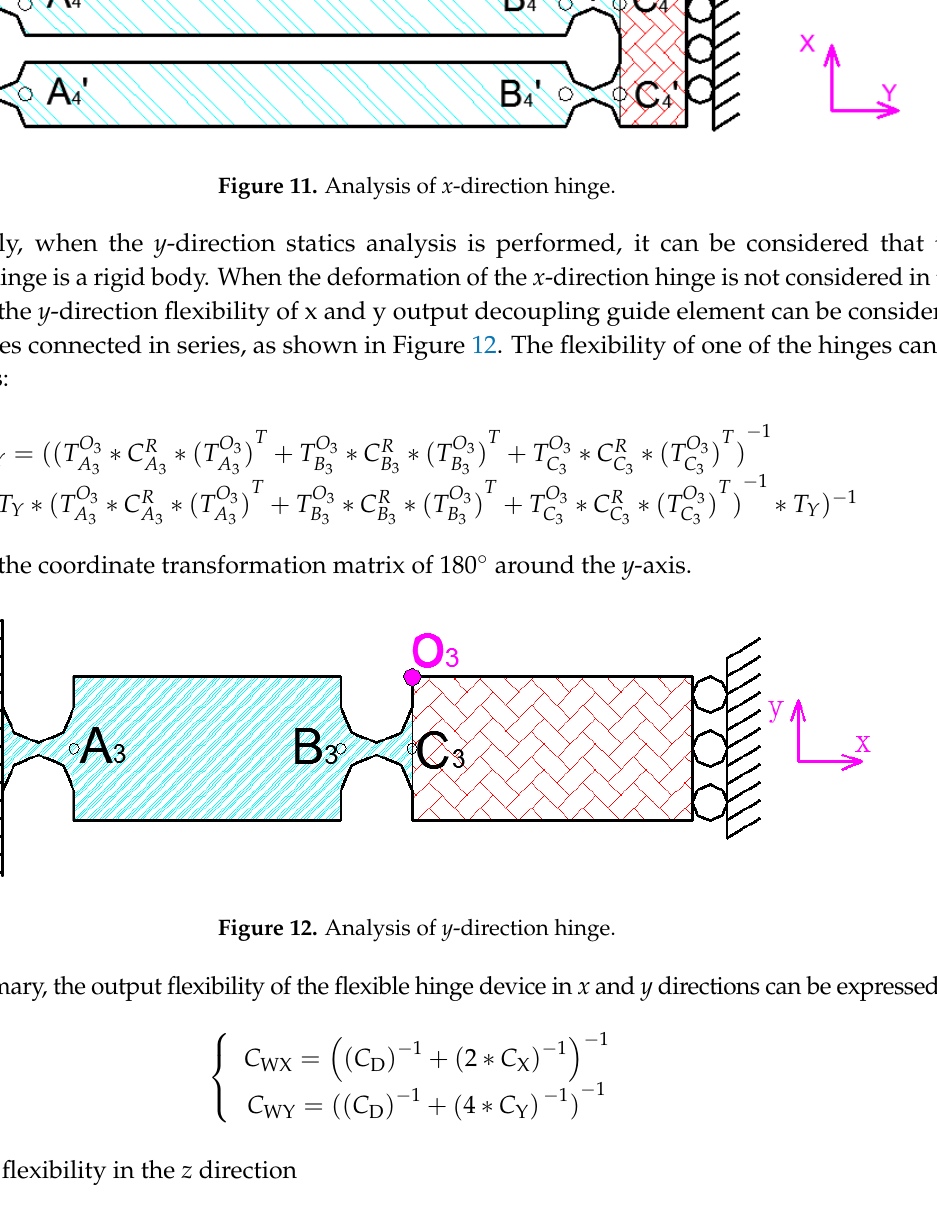
Figure 13. Analysis of z -direction hinge. When the flexibility of the z -direction hinge mechanism is calculated, the influence of 2D motion platform on the z -direction flexibility can be ignored. Therefore, the flexibility of the z -direction hinge device can be expressed as: wz